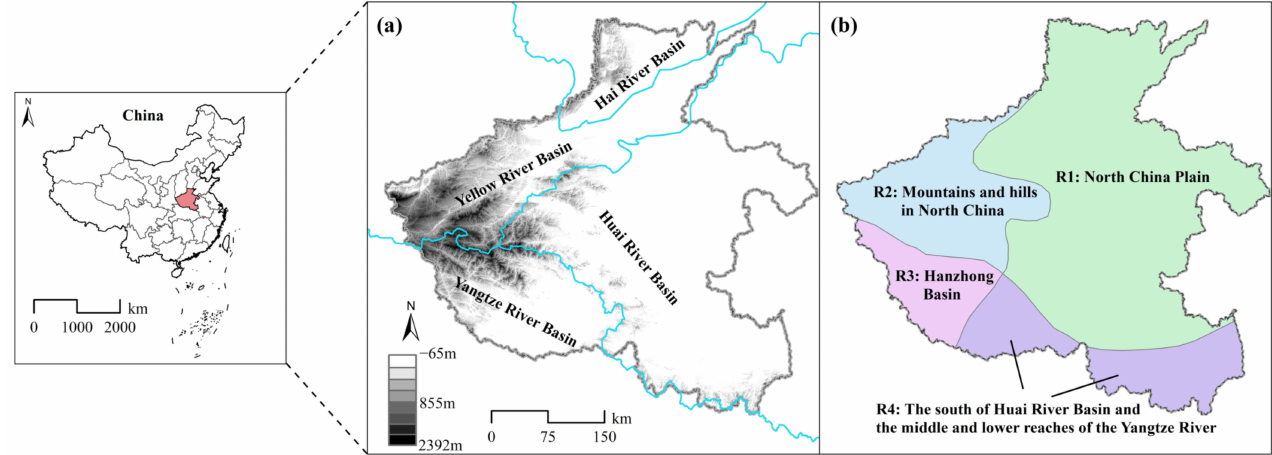
Figure 1. Geographical location of Henan Province in China. ( a ) Four basins and ( b ) ecogeographical